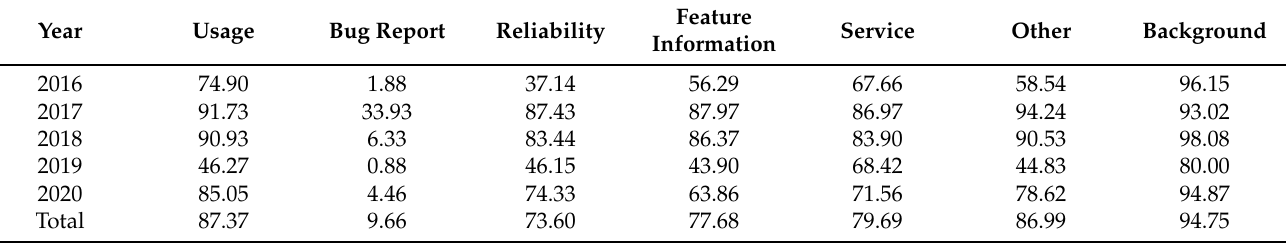
Table 4. User satisfaction scores of Ping An Health App in various dimensions from 2016 to